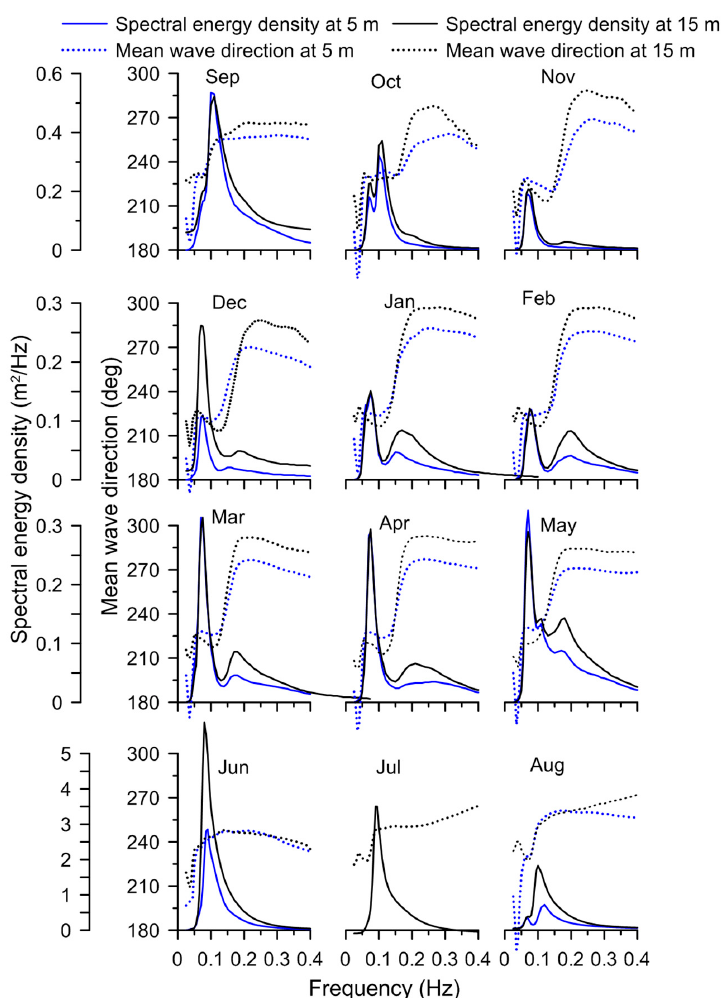
Figure 4. Monthly averaged wave spectrum showing the variation of spectral energy density and mean wave direction at both 15 and 5 m water depth.